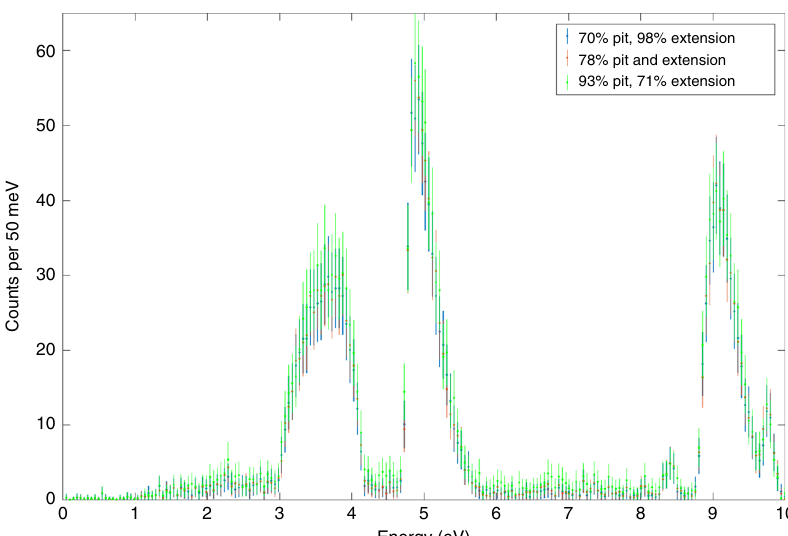
Fig. 6 Simulations of spectra of the transmitted epithermal neutron count mean values. The target consisted of a pit-reciprocal and an extension of various levels of 239 Pu enrichment. The results show that the data would make it impossible to determine the enrichment of the pit beyond the 70 – 93% range. The error bars re fl ect the statistical uncertainty of an expected measurement with 1.0 × 10 7 incident neutrons, which is more than suf fi cient for achieving the 5 σ hoax detection